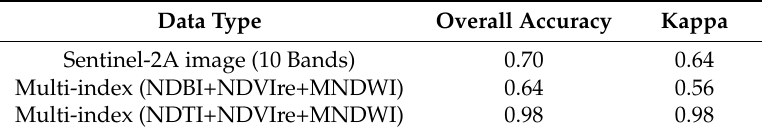
Table A2. Comparison of the overall accuracy and the Kappa statistics for Figure 8.